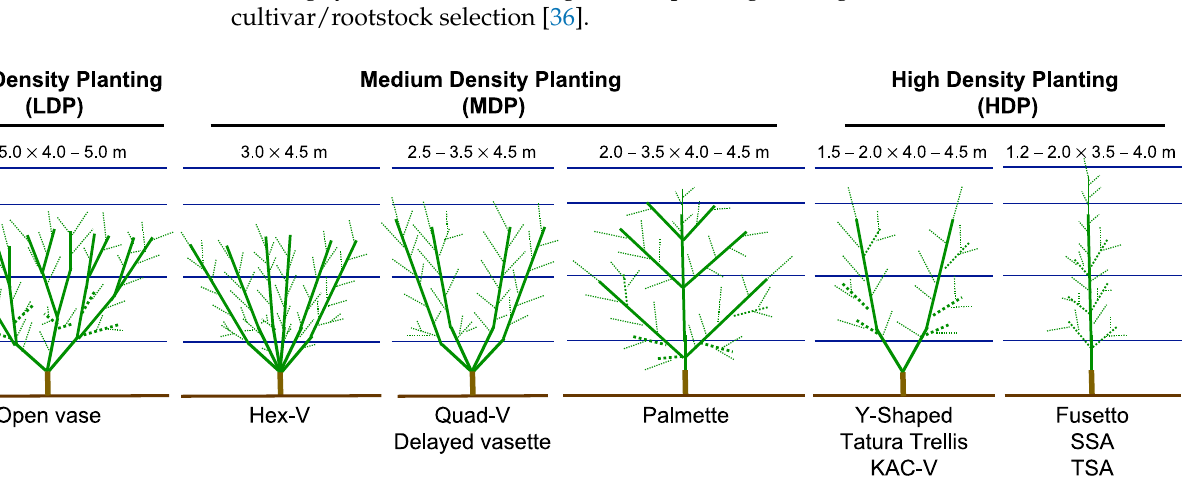
Table 2. Training systems and their associated orchard design characteristics.